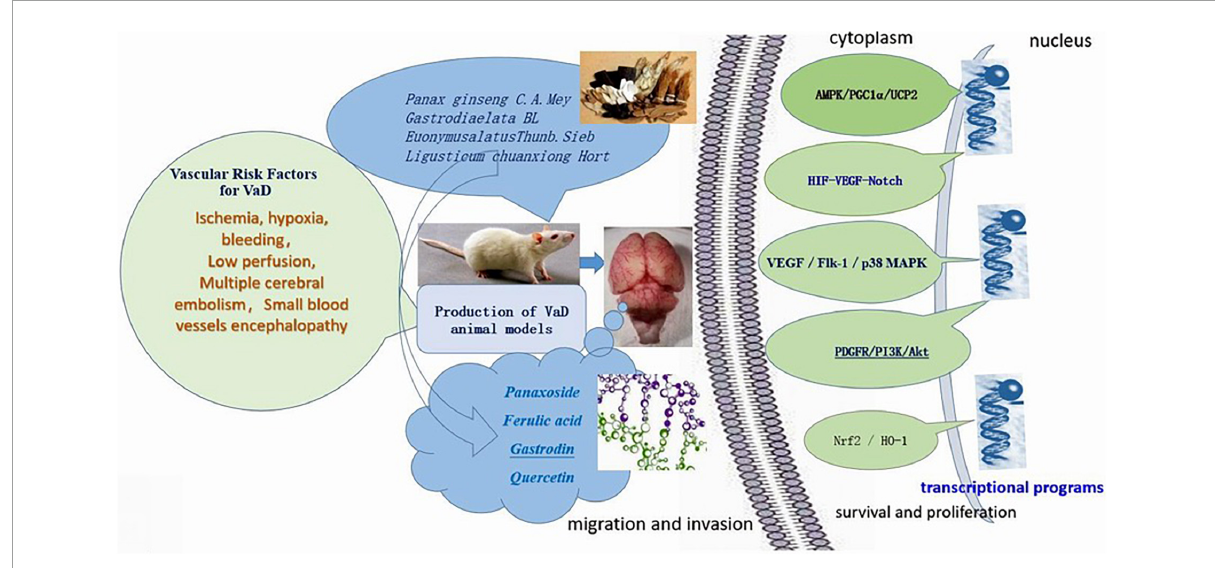
FIGURE5 Signaling pathways of Shen Ma Yi Zhi granule (SMYZG) in the context of vascular dementia (VaD) treatment. Sources for the images within this figure: 699pic.com and Chinese Pharmacopoeia.